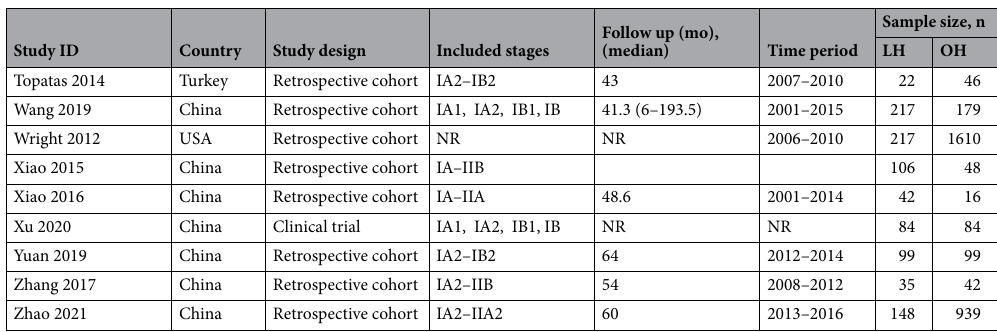
Table 1. Summary of the included studies. NR not reported, mo